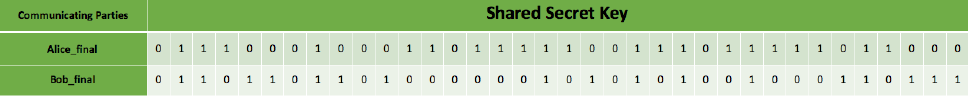
Figure 17. Sender and receiver final shared key mismatch with the eavesdropper’s